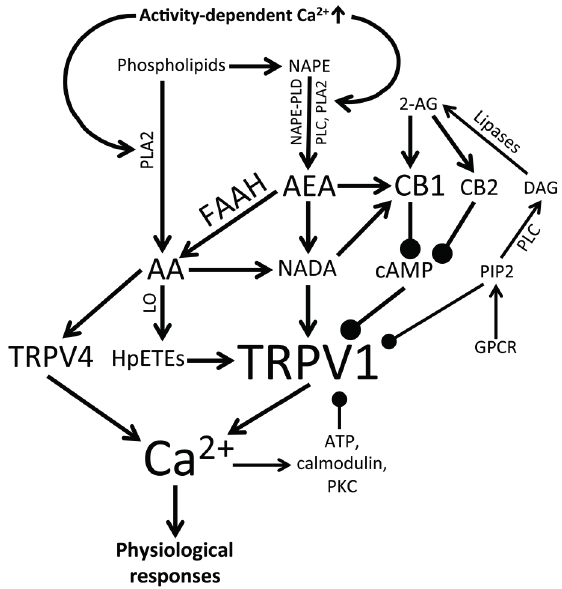
Figure 3. Cellular activity initiates synthesis of endocannabinoids/endovanilloids,